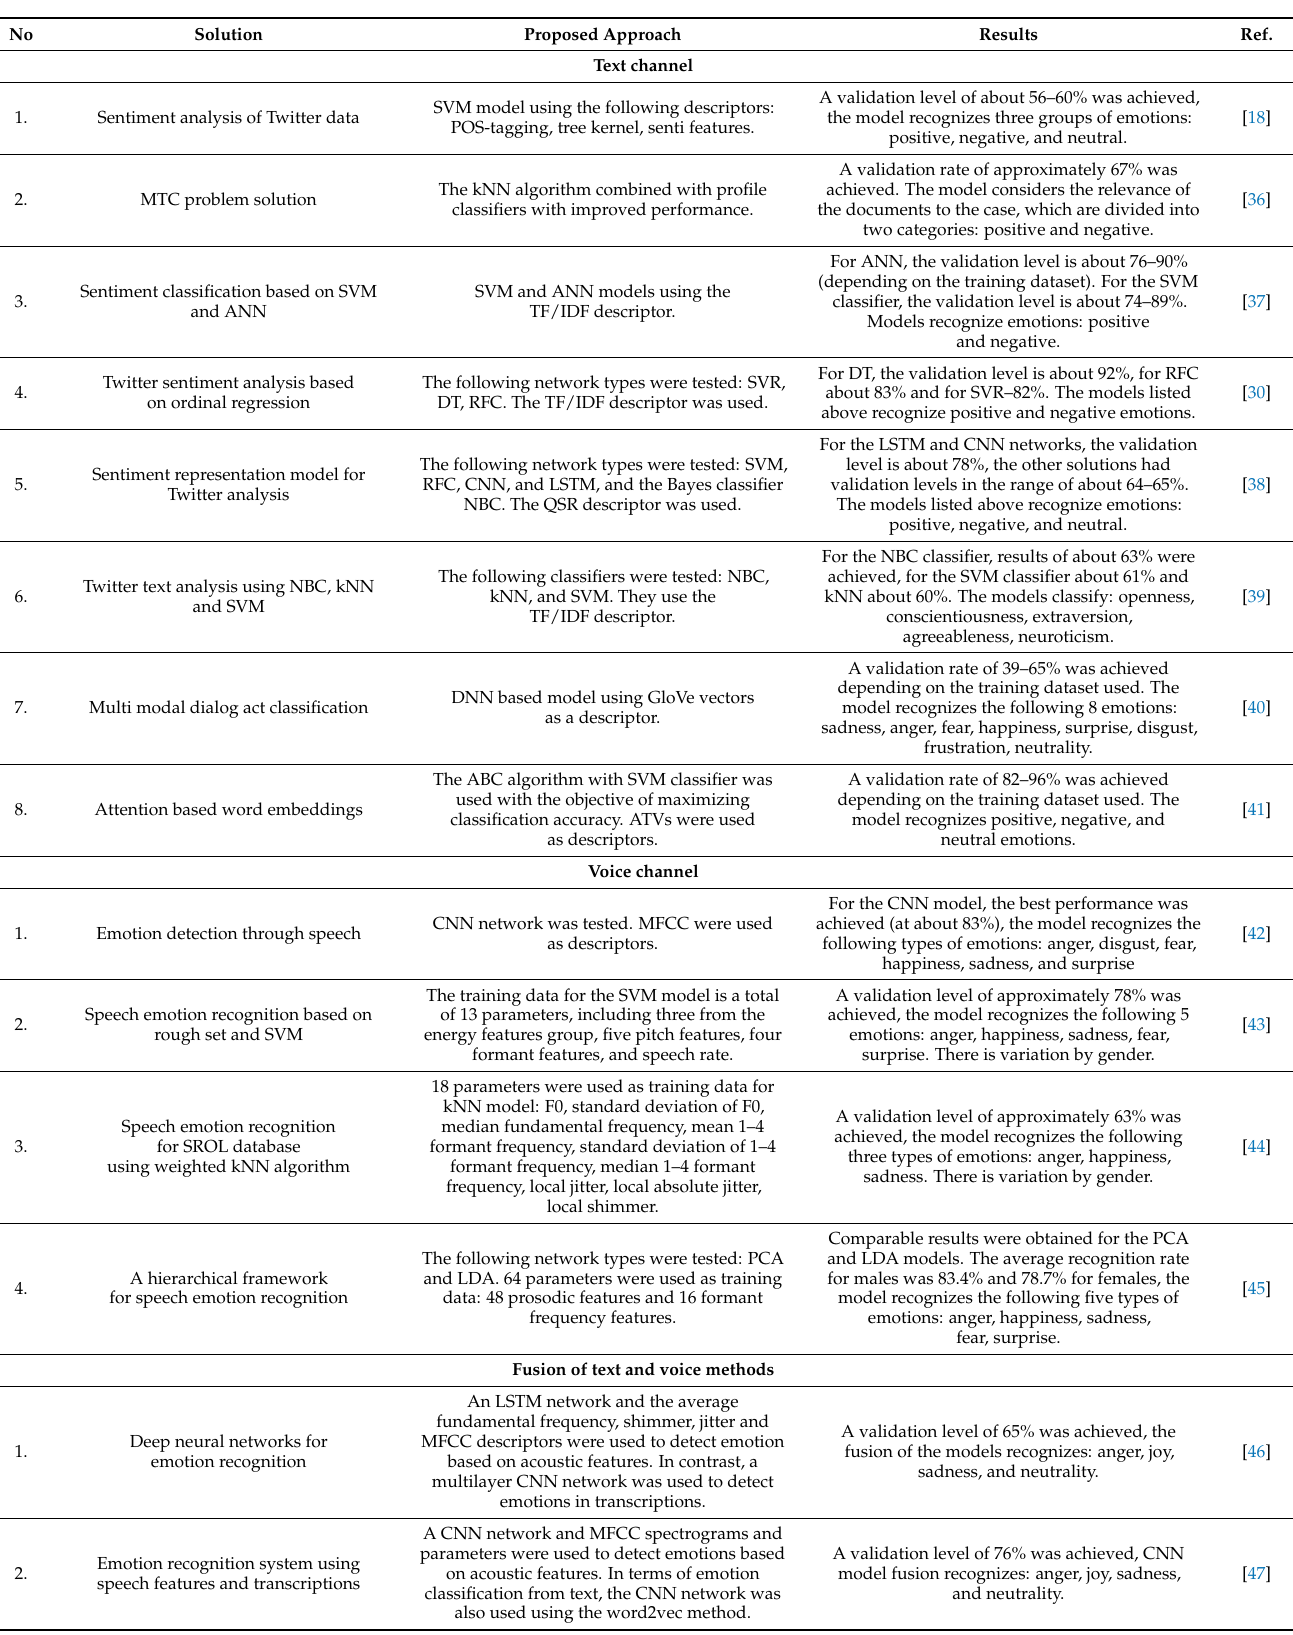
Table 1. Analysis of selected solutions for emotion classification methods in text and audio